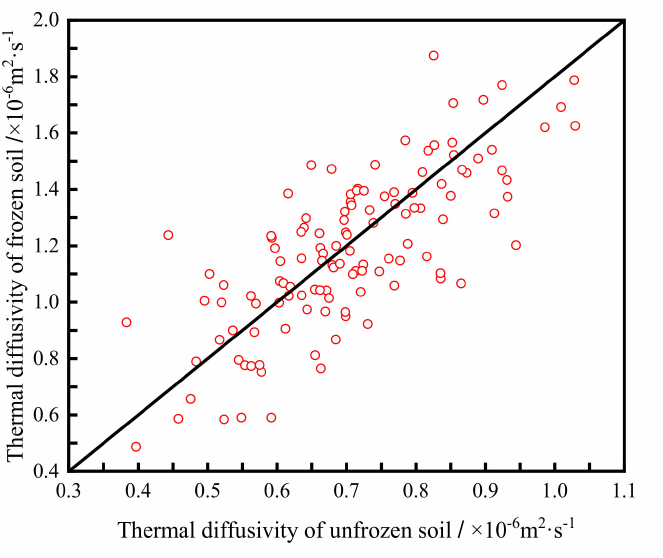
Figure 10. Distribution of thermal diffusivity of frozen and unfrozen